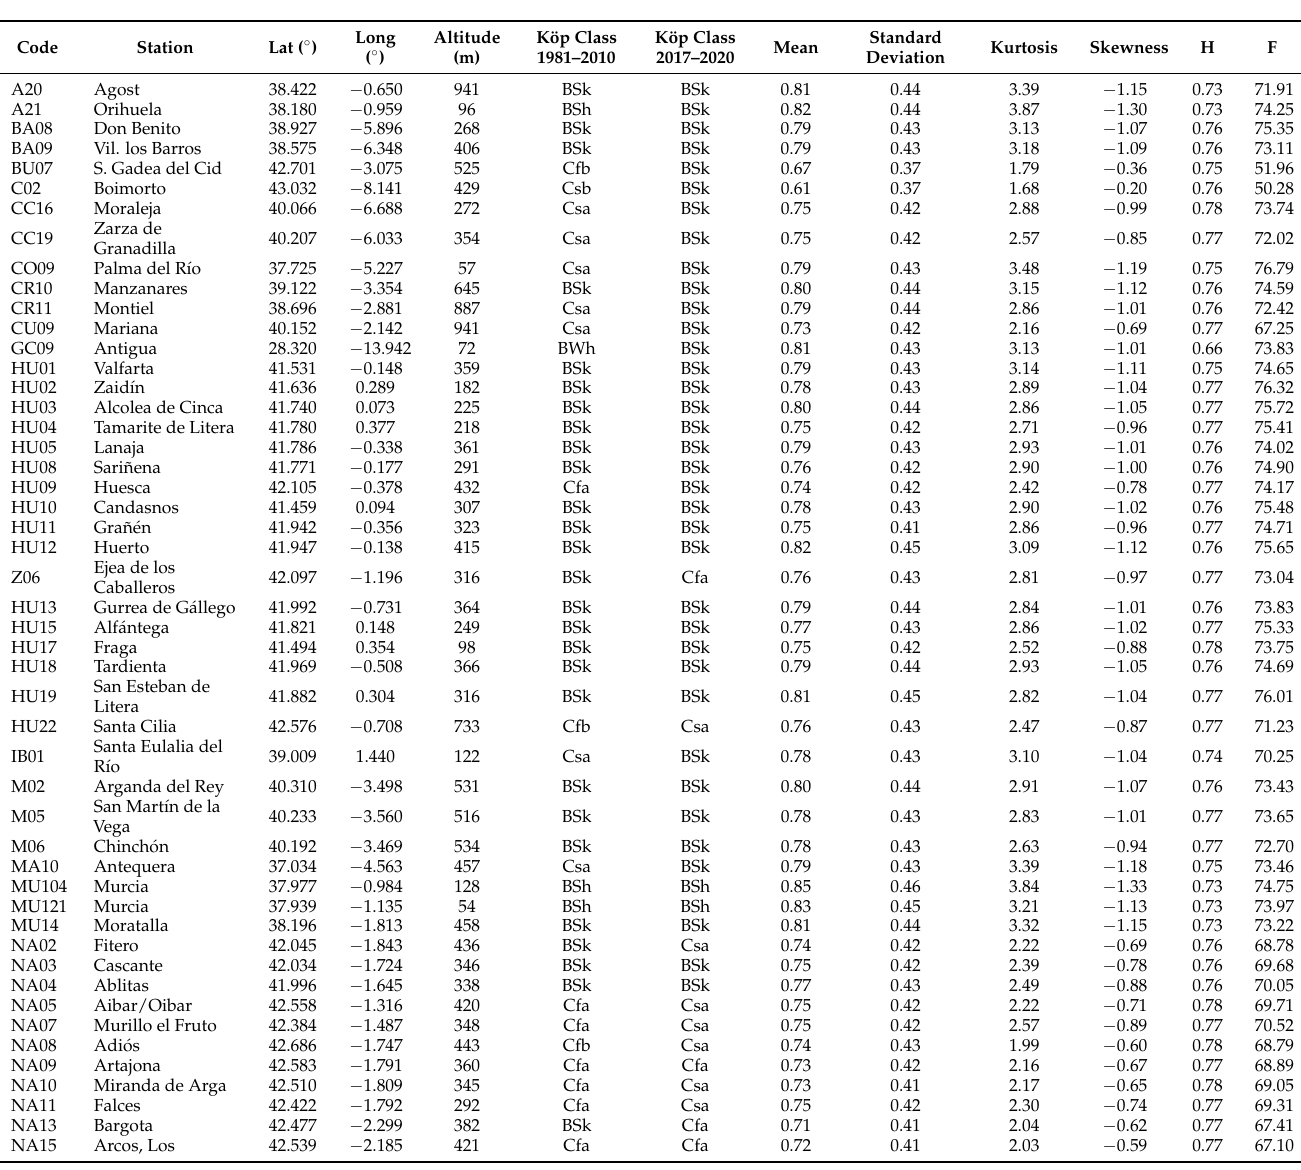
Table A1. Time-series characterization